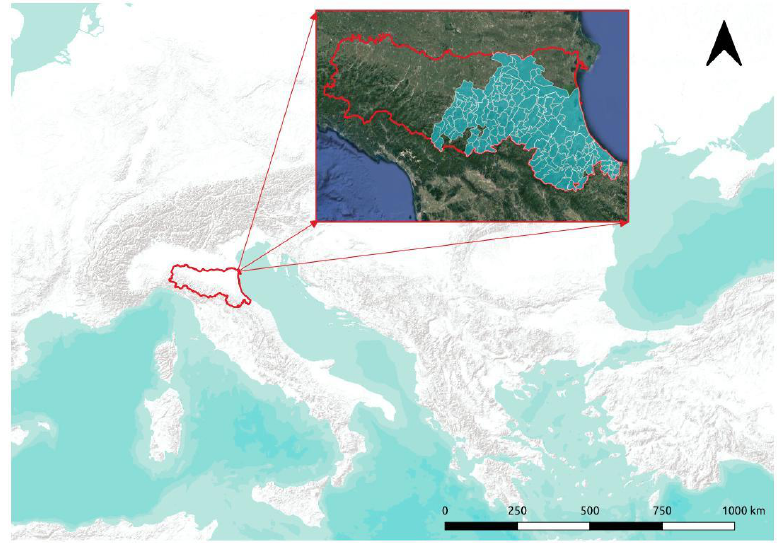
Figure 1. Case study area: the Emilia-Romagna region and all the municipalities of the seven dis- Figure 1. Casestudyarea: theEmilia-Romagnaregionandallthemunicipalitiesofthesevendistricts analyzed. tricts analyzed.